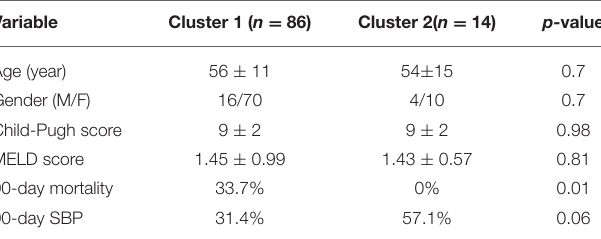
TABLE 1 | Clinical characteristics of patients with different ascitic microbiota